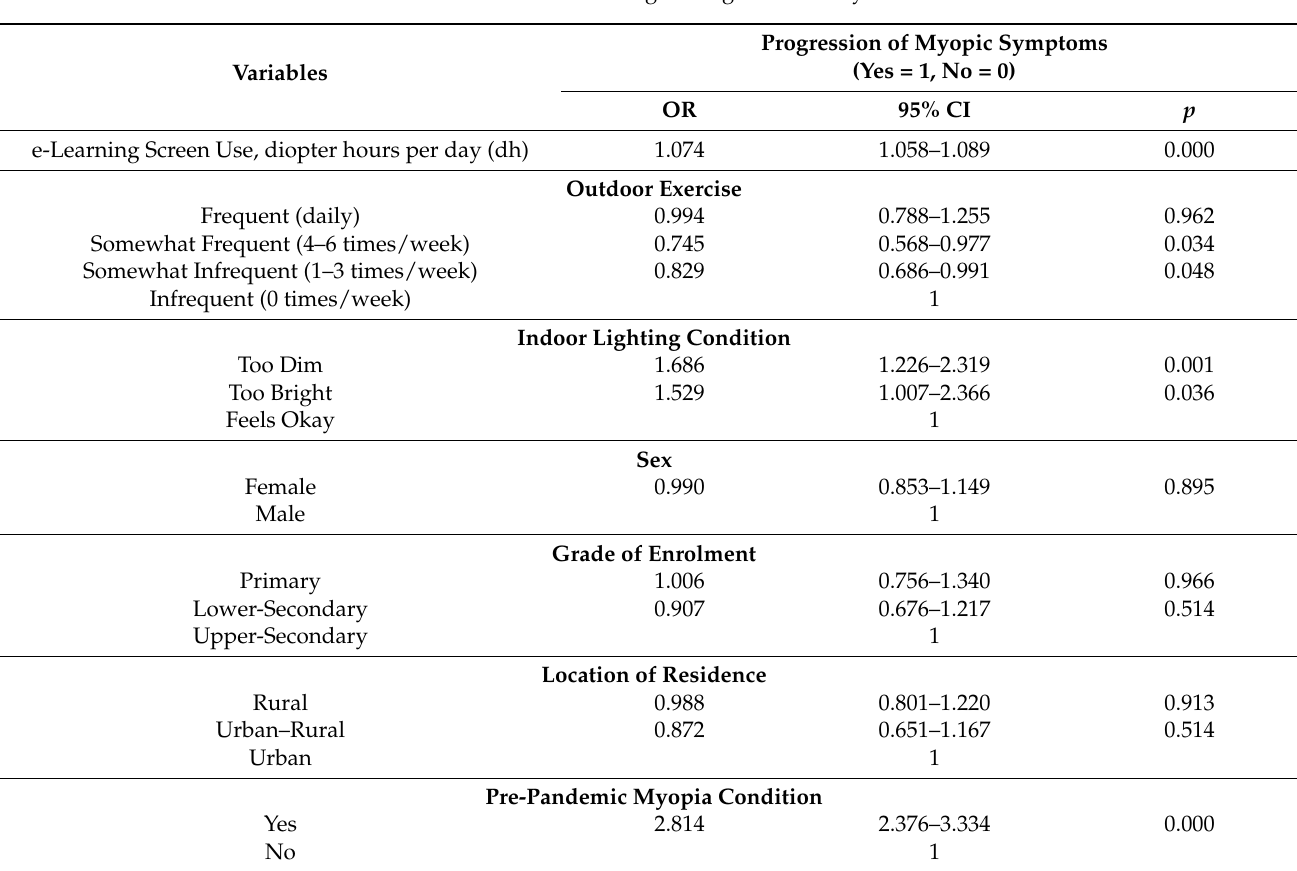
Table 2. Multivariate logistic regression